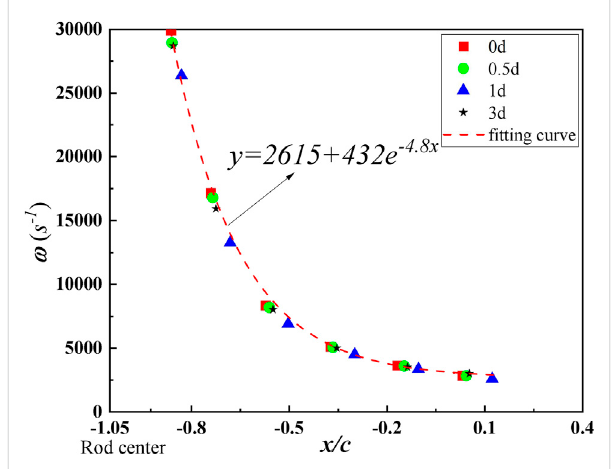
FIGURE 10 Changes in the strength of the vortex center between the rod airfoil with different offsets.